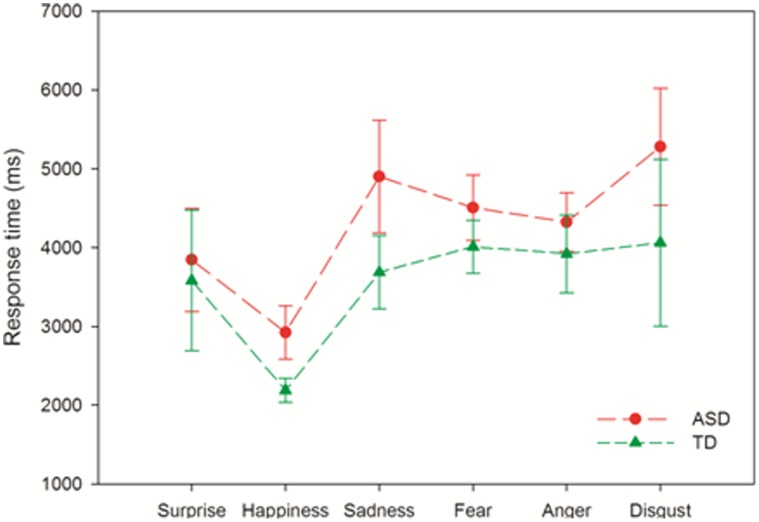
Response times for identifying specific emotions in ASD (red) and control (green) participants.